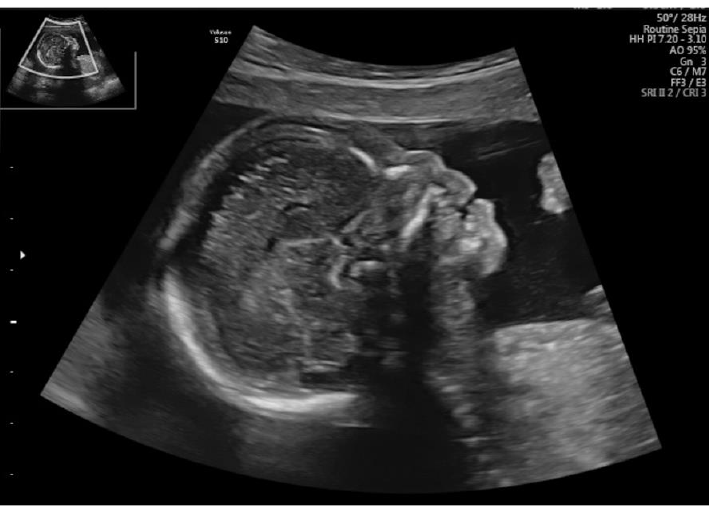
Figure 2. Fetus with Pallister – Killian